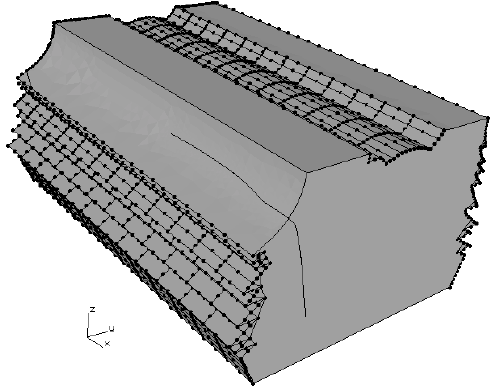
Figure 17. The 60°, long flank crack shape.